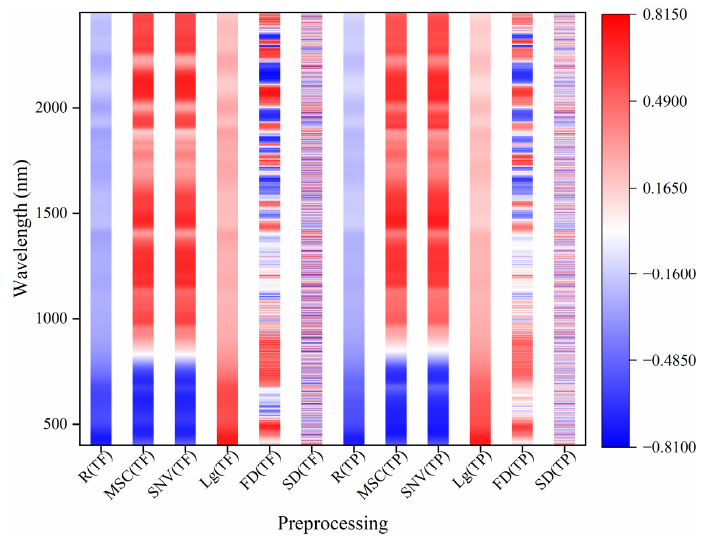
Figure 2. Correlation between transformation spectra and total flavonoids and total phenols in grains. R, TF, and TP mean the original spectrum, total fl avonoids, and total phenols; the same ap- plies below.